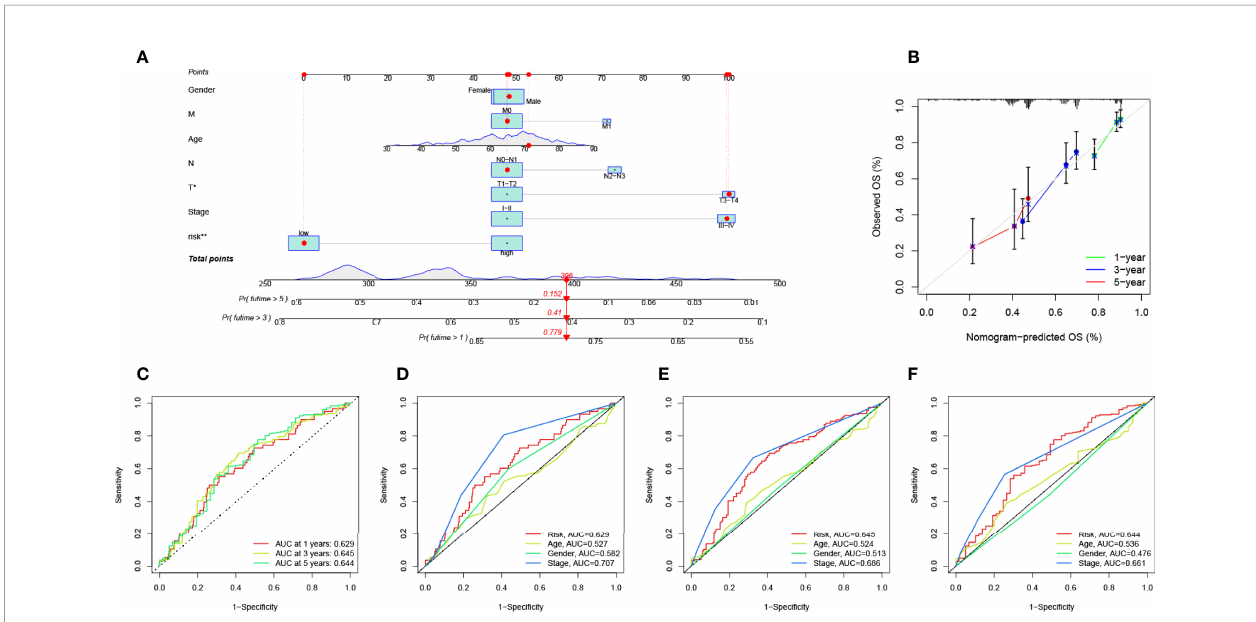
FIGURE 7 | Validation of prognostic ef fi ciency of risk signatures. (A) The nomogram was used to predict survival in LUAD patients. (B) One-, 3-, and 5-year nomogram calibration curves. (C) ROC analysis was used to estimate the predictive value of prognostic features. The area under the (D – F) curve (AUC) of the risk score for predicting overall survival at 1, 3, and 5 years and other clinical